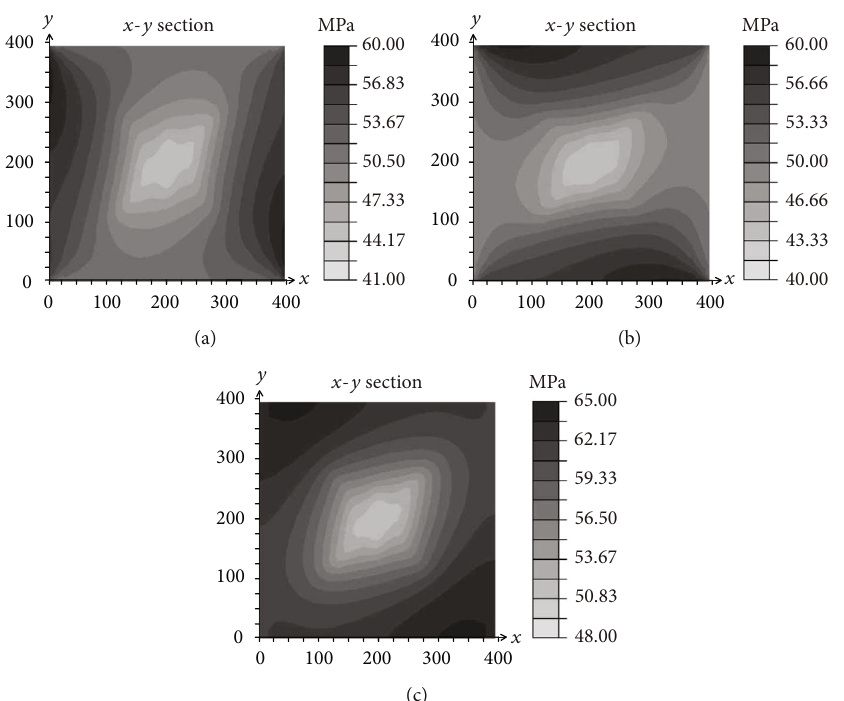
Figure 18: (a), (b), and (c) present the σ of natural